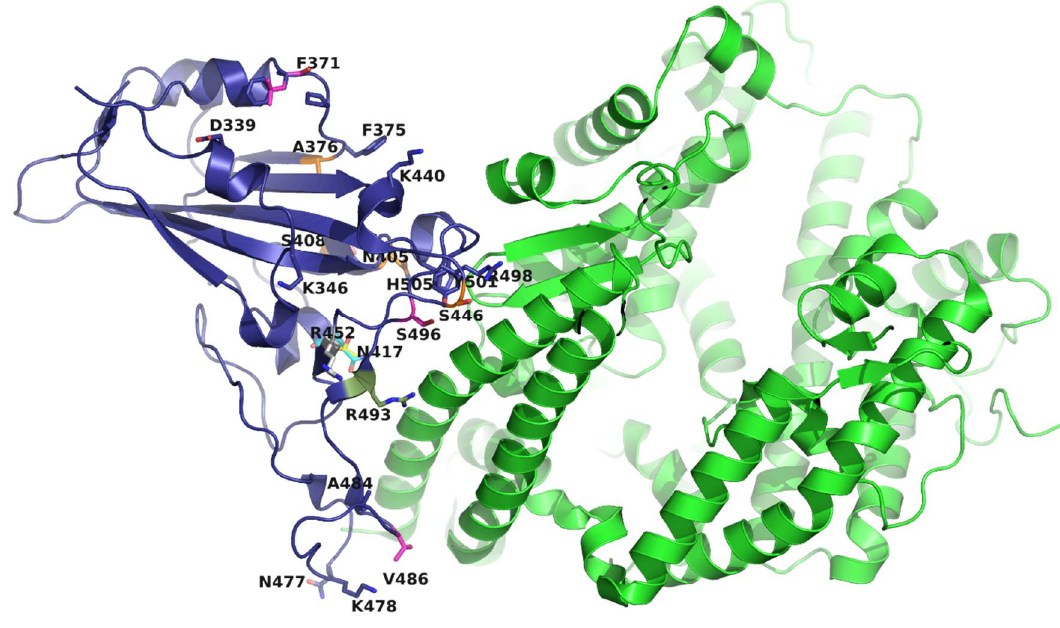
Figure 2. Mutations in the S-RBD of Omicron and its sublineages (see Figure 3a). The S-RBD (purple) and ACE2 (green) are rendered as ribbons. Mutations (shown as sticks) in 8 or more sublineages are colored purple; mutation in one sublineage is colored yellow; mutations in 2, 3, 4, 5, and 6 sublineages are colored magenta, gray, orange, cyan, and forest green, respectively. This figure was generated using the PDB file 6M0J [15].